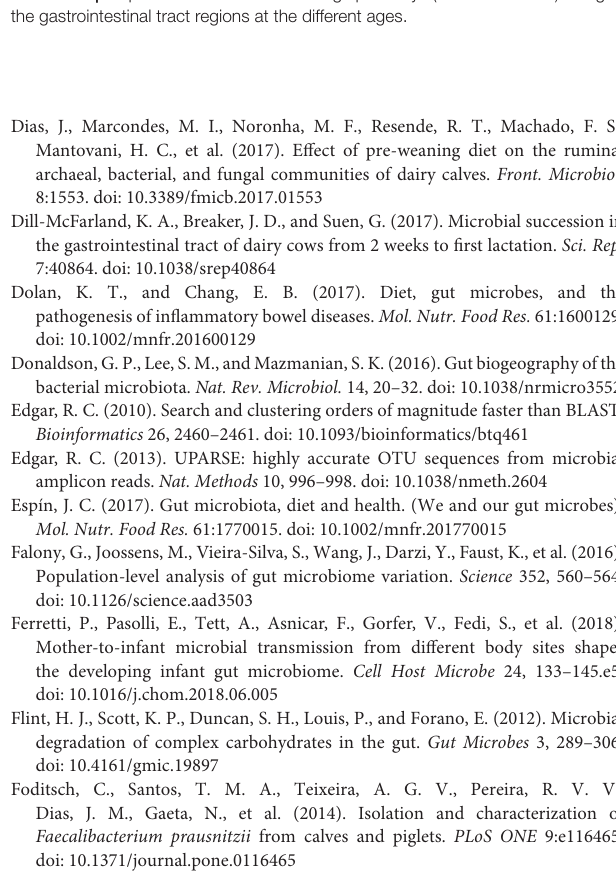
lowercase letters within the same column differ significantly (P < 0.05). The same as below in Table S6. Table S4 | Analysis of similarity (ANOSIM) of bacterial microbiota according to age in each gastrointestinal tract (GIT) region. This analysis provides a way to statistically test whether there is a significant difference between two or more groups of samples, by generating a similarity value (R-value) between 0 and 1 using the Bray-Curtis index. R-values closer to 0 represent groups that do not significantly differ, while values closer to 1 represent a highly different community composition. All ANOSIM values were significantly different between the groups at P < 0.01. The same as below in Table S7. Table S5 | Significant difference of 23 genera at different ages in rumen, duodenum, jejunum, ileum, cecum, and colon. Mean values with different superscripted lowercase letters within the same row differ significantly (P < 0.05). Table S8 | Significant difference of 23 genera at different gastrointestinal tract (GIT) regions in each age group. Table S9 | The nearest sequenced taxon index (NSTI) for each sample. The NSTI is used to measure the dissimilarity between the predicted metagenome presented here and reference genomes. Table S11 | 36 predominant KEGG orthologs pathways (at KEGG level 3) along the gastrointestinal tract regions at the different